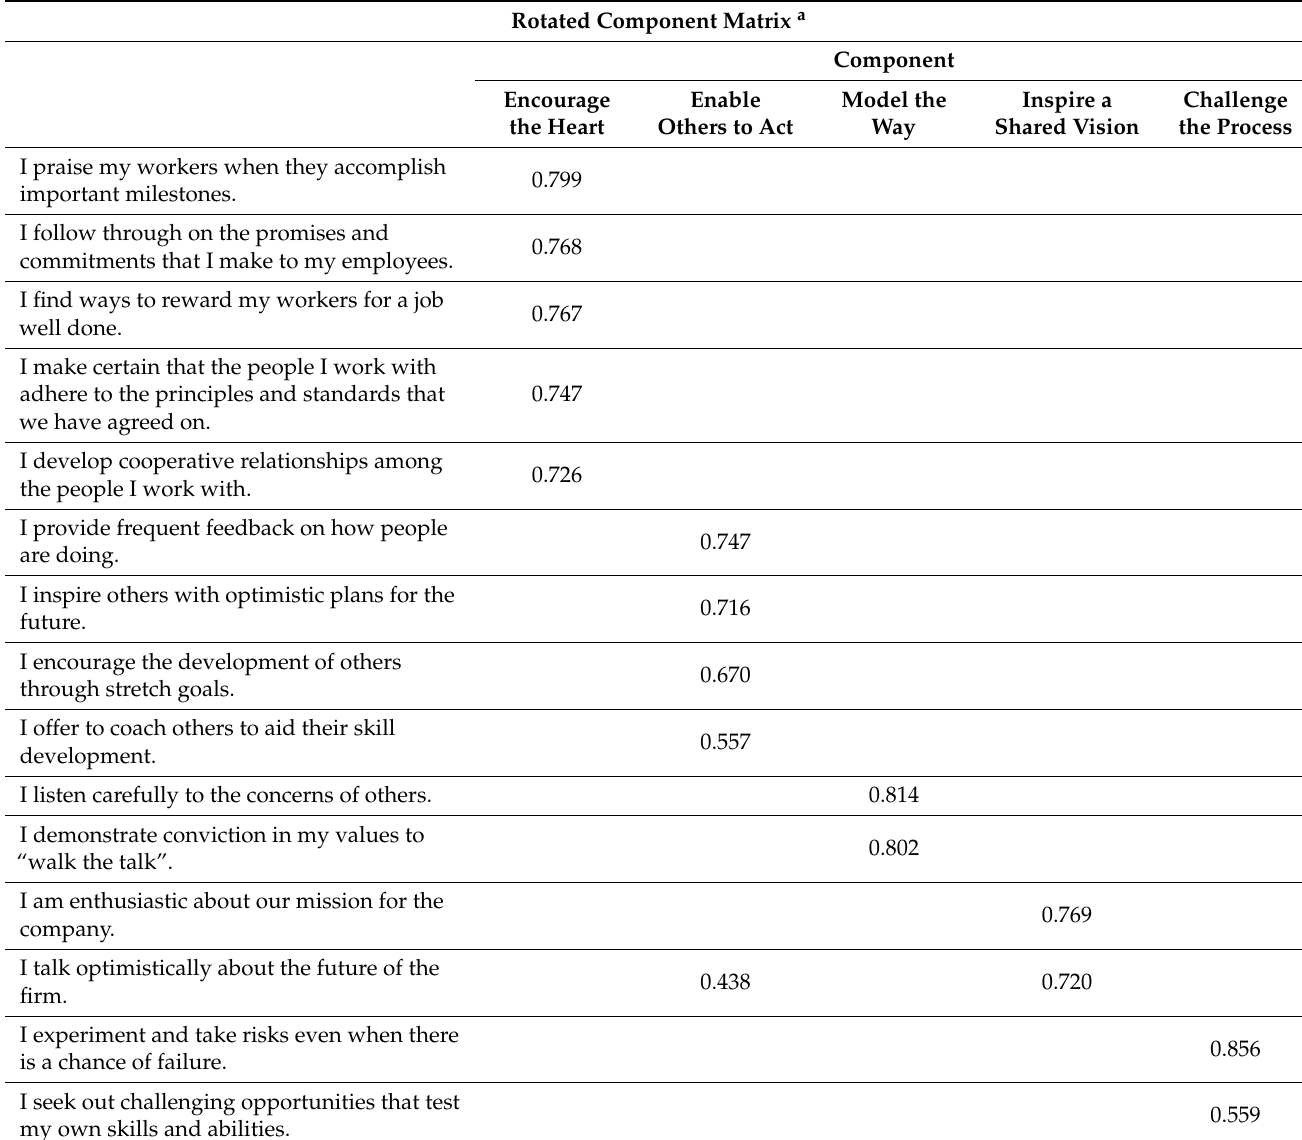
Table 2. Principal axis factor analysis Study 1. Rotated Component Matrix